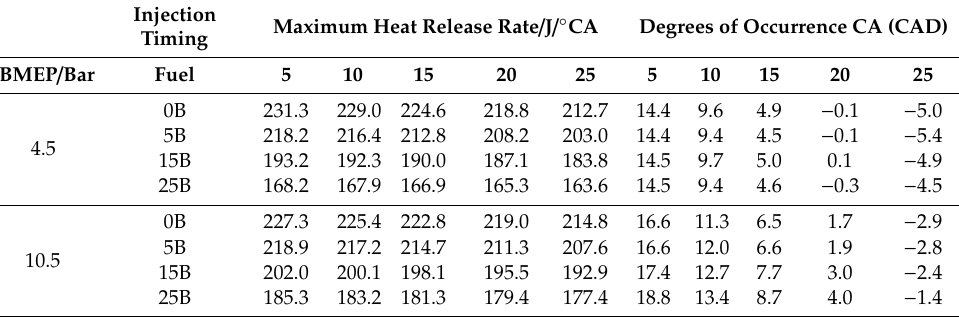
Table 5. Maximum heat release